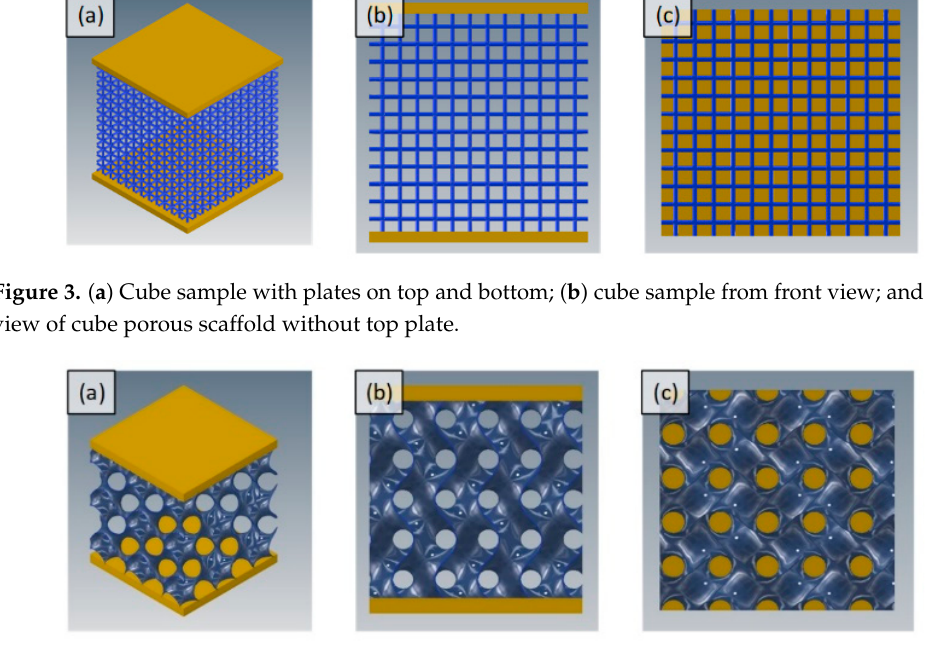
Figure 4. ( a ) Gyroid sample with plates on top and bottom; ( b ) gyroid sample from front view; and ( c ) top view of gyroid porous scaffold without top plate.